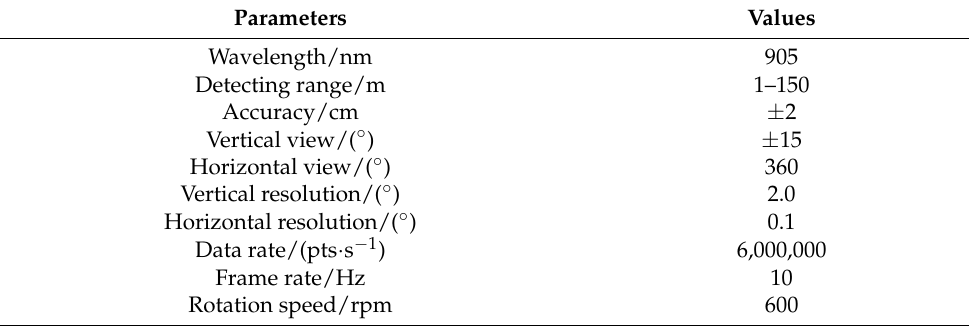
Table 1. Parameters of LiDAR.